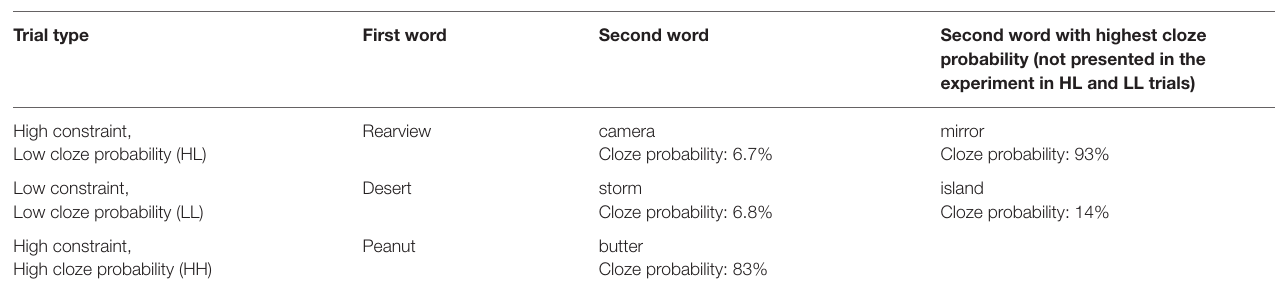
TABLE 4 | Example materials for Experiment